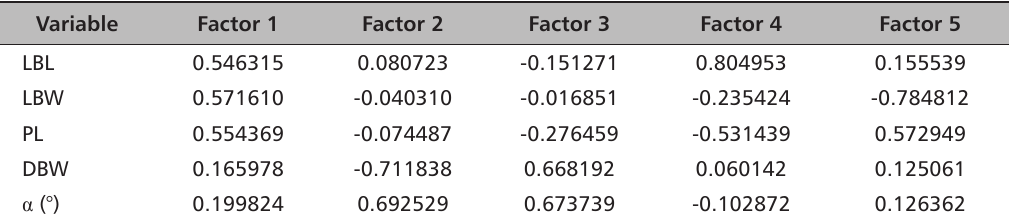
taBle 6. Factor-variable correlations (factor